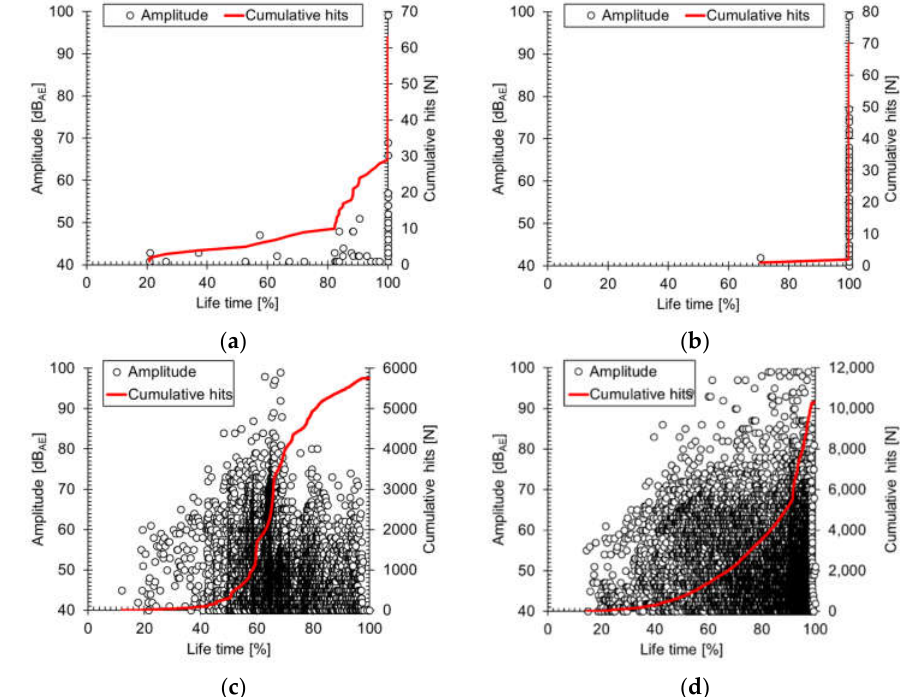
Figure 5. Variation in stress with change in amplitude (black dot) and cumulative hits (red line) over the lifetimes of ( a ): [90] 16 , ( b ): [80] 16 , ( c ): [0] 8 , and ( d ): [0/90] 4 specimens under the tensile test.